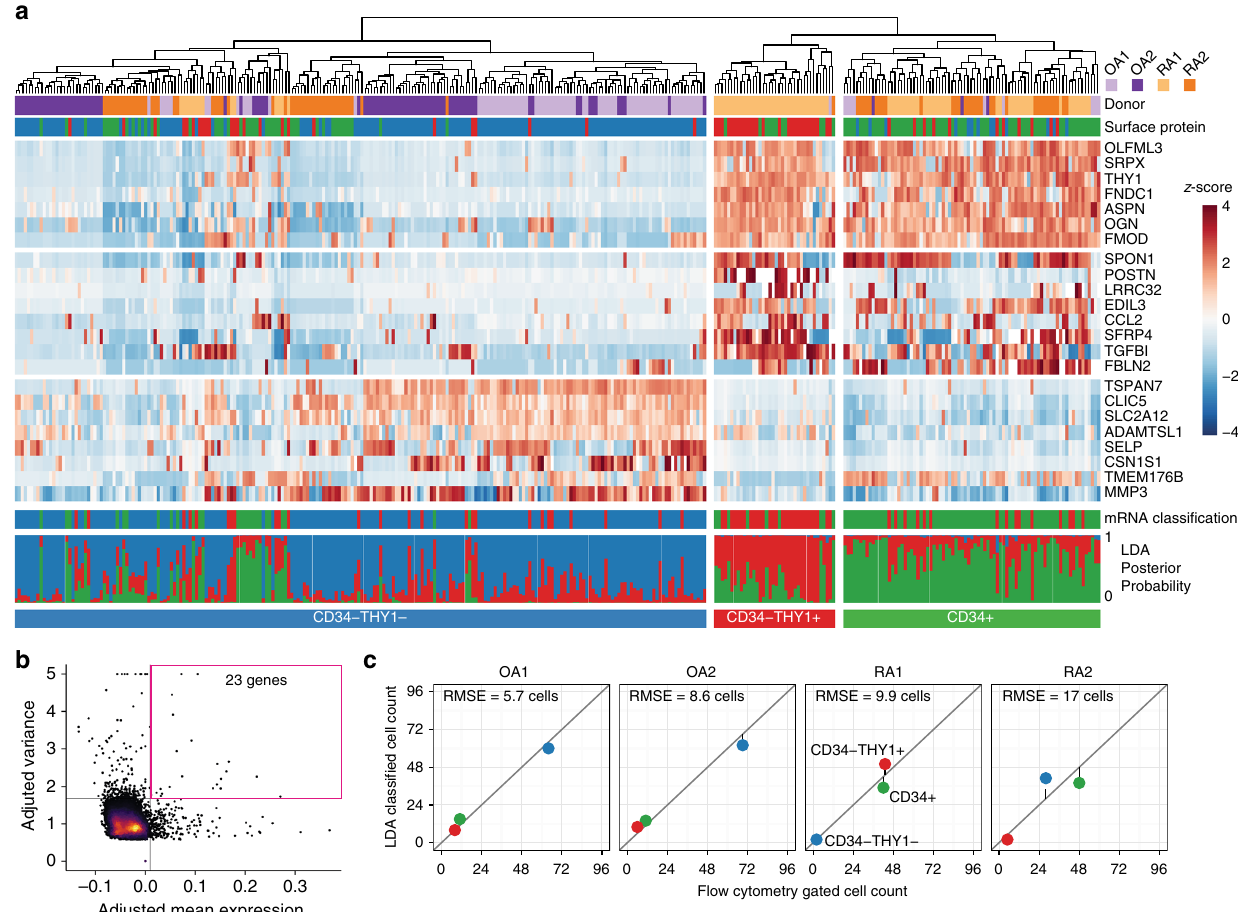
Fig. 2 Unbiased clustering of fi broblasts by single-cell RNA-seq. a Hierarchical clustering is concordant with our surface protein gating. The fi rst track indicates which donor the cell came from. The second track indicates which cell sorting gate the cell falls into, by surface protein expression. The heatmap indicates mRNA expression, scaled across cells to reveal variation between cells. Below the heatmap, the fi rst track shows linear discriminant analysis (LDA) classi fi cation by mRNA expression of 968 genes. The last track shows posterior probabilities of LDA classi fi cation. b For the heatmap, we selected 23 genes with greatest 1% mean and greatest 1% variance in expression levels. c The number of cells in each subset as determined by surface protein levels ( x -axis) and by LDA classi fi cation ( y -axis) is consistent. RMSE, root mean squared